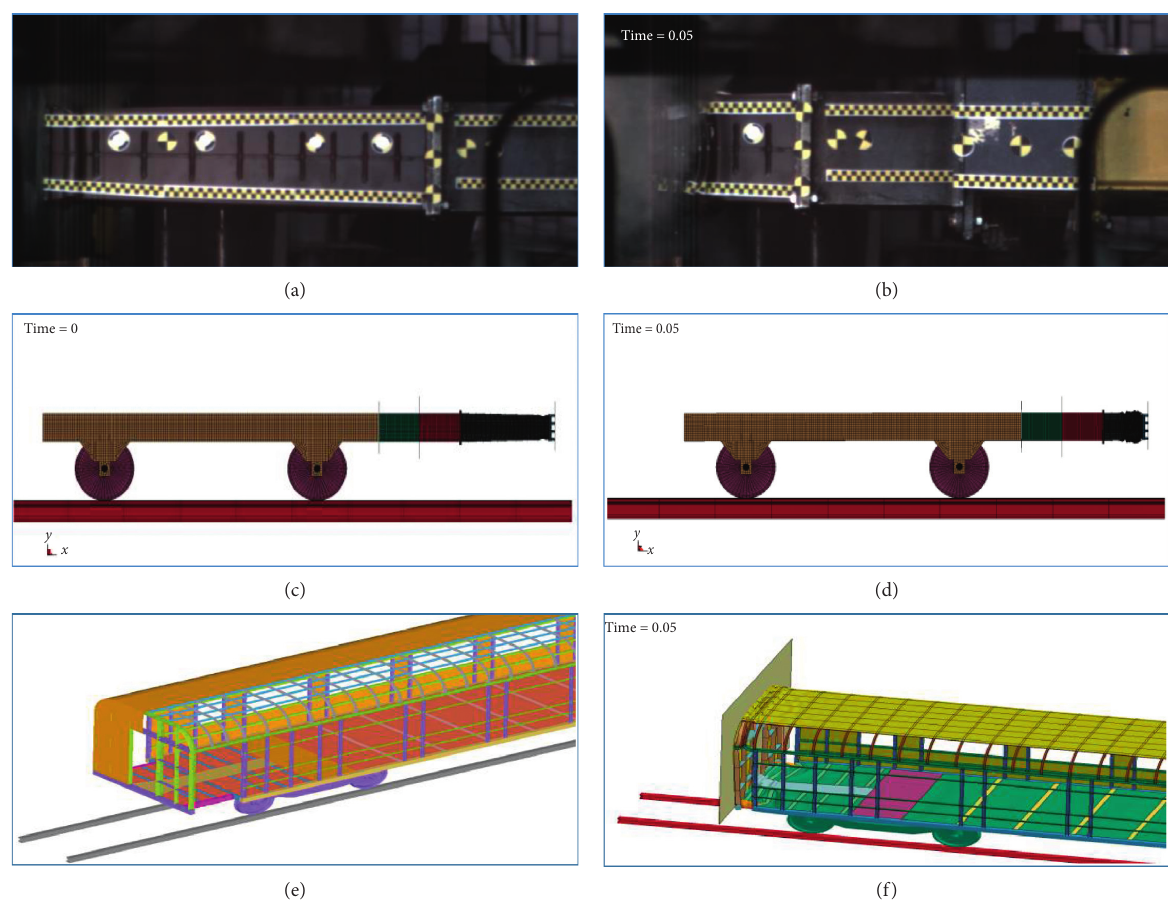
Figure 2: Cash experiments and FEM simulation. (a) Experimental state of energy absorbing device at initial time. (b) Experimental results of energy absorption device at initial speed of 60km/h, t � 50ms. (c) FE model of energy absorbing device. (d) FE model simulation results of energy absorption device at initial speed of 60km/h, t � 50ms. (e) FE model of intermediate car. (f) FE simulation results of the intermediate vehicle model at 60km/h and t � 50 ms.